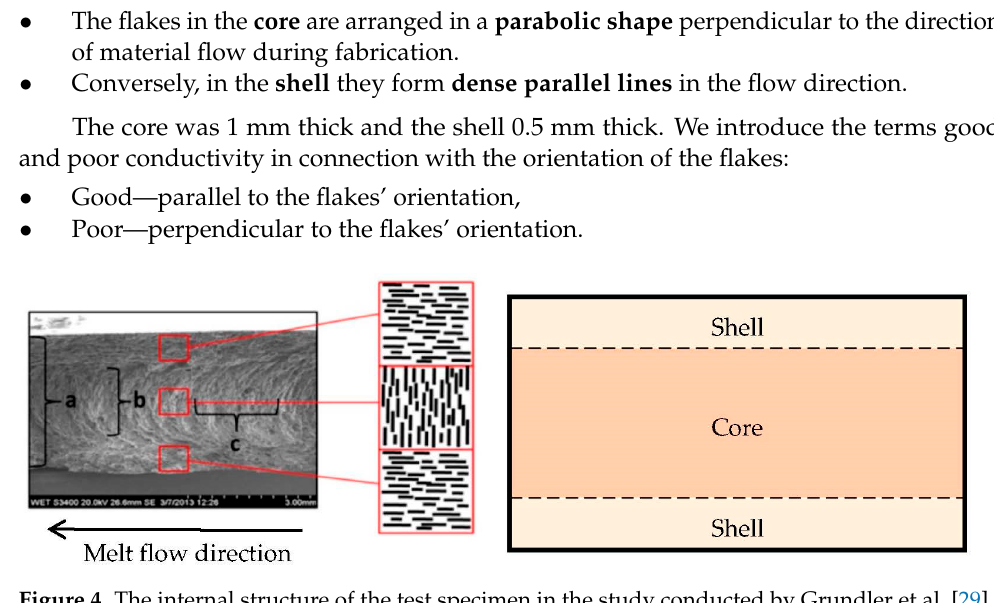
Figure 3. Locations of the thermocouples inside the heat sink. The locations in the middle fin will be referred to as Tmx, x being the ordinal number from the base up to the fin, e.g., Tm1—thermocouple in the base under the middle fin. Similarly, the locations of thermocouples in the outer fin will be labelled as Tsx. Dimensions are in mm.